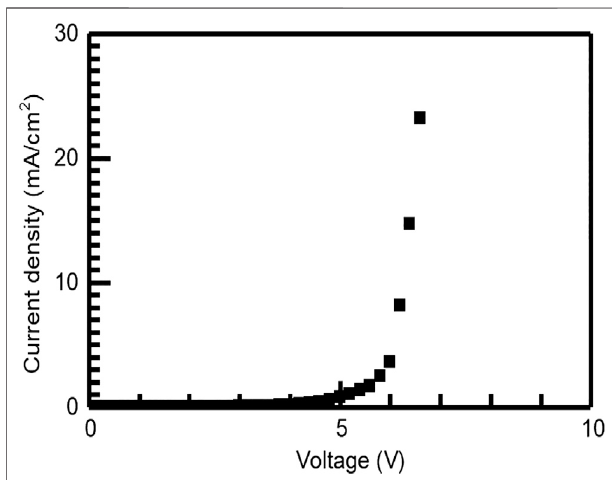
FIGURE 6 | Current density – voltage curve of MA 0.6 FA 0.4 PbI 2.8 Br 0.2 perovskite solar cells operating in the light-emitting